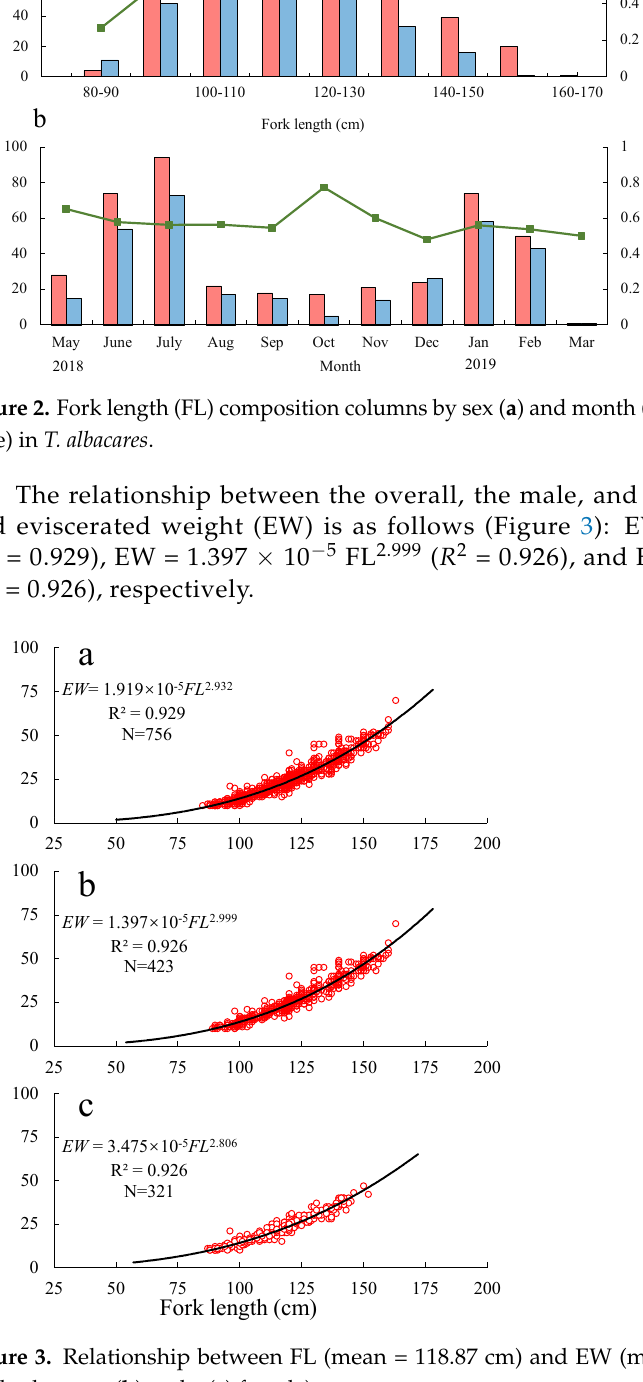
Figure 3. Relationship between FL (mean = 118.87 cm) and EW (mean = 24.67 kg) of T. albacares (( a ) both sexes; ( b ) male; ( c ) female).